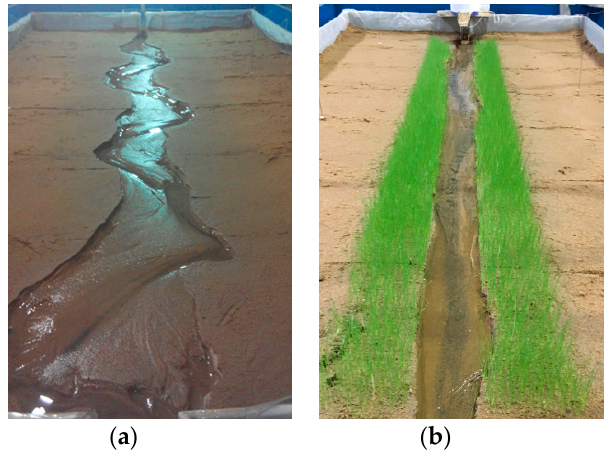
Figure 11. Final relative steady state: ( a ) 0% riparian vegetation coverage rate; ( b ) 80% riparian